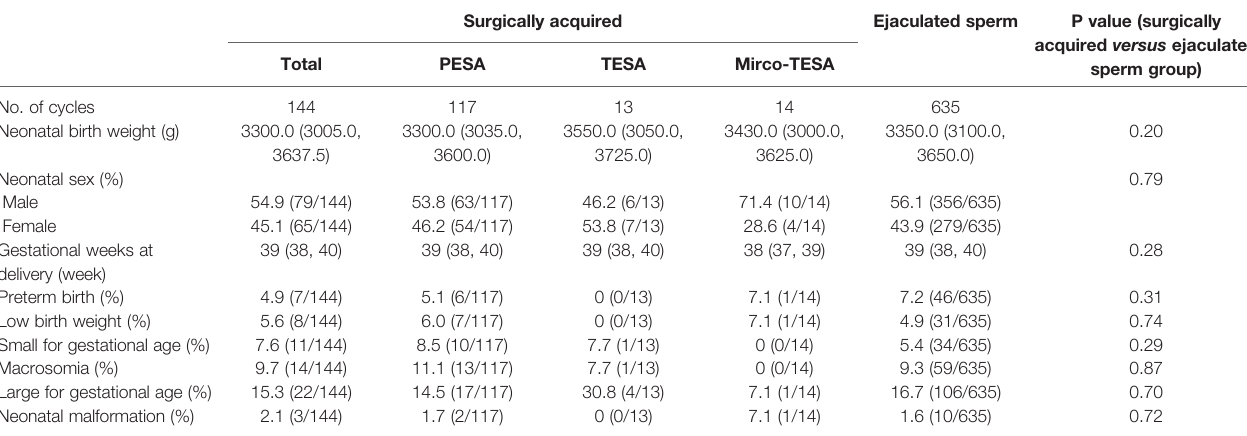
TABLE 3 | Singleton neonatal outcomes of the